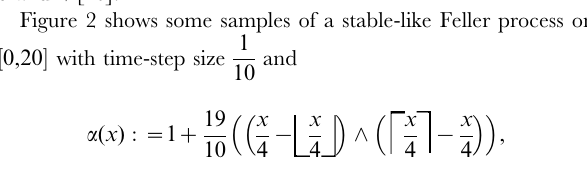
Figure 3. Normal inverse Gaussian-like processes with b x ð Þ : ~{ doi:10.1371/journal.pone.0015102.g003 PLoS ONE |